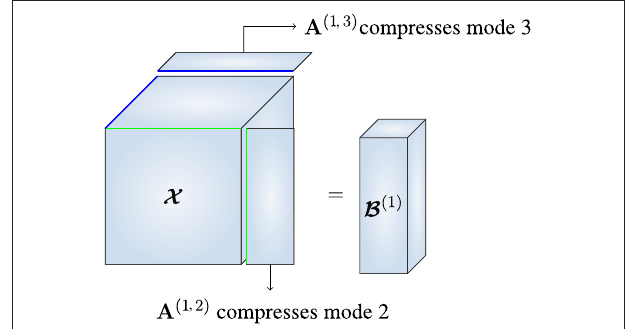
FIGURE 1 | Similar to the RTD algorithm in Che et al. [15], we recover the first MLSVD factor matrix from B (1) , which is a version of X that is compressed in every mode except the